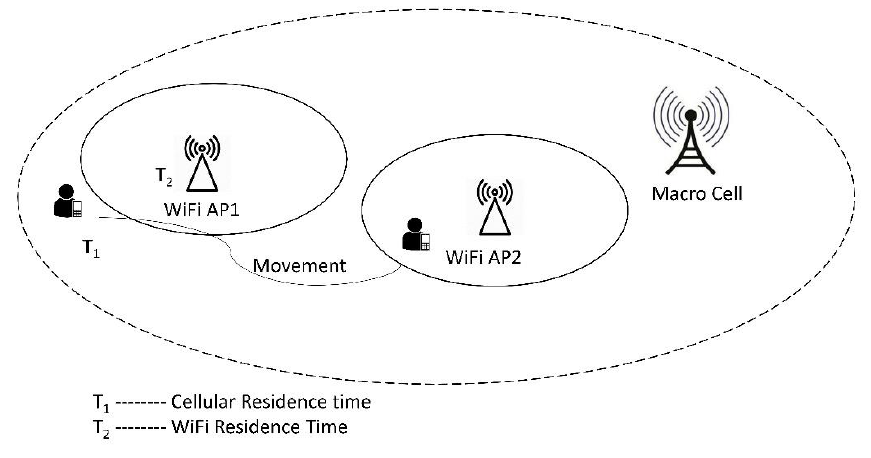
Figure 2. User movement over heterogeneous